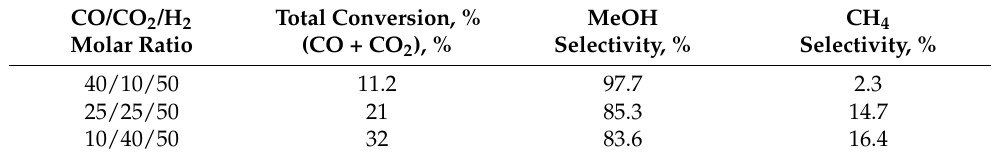
Table 4. Conversion values and product distribution of CZA catalysts for methanol synthesis at different feed compositions (T = 275 ◦ C; P = 50 bar; space-time of 0.72 s.gcat/mL).